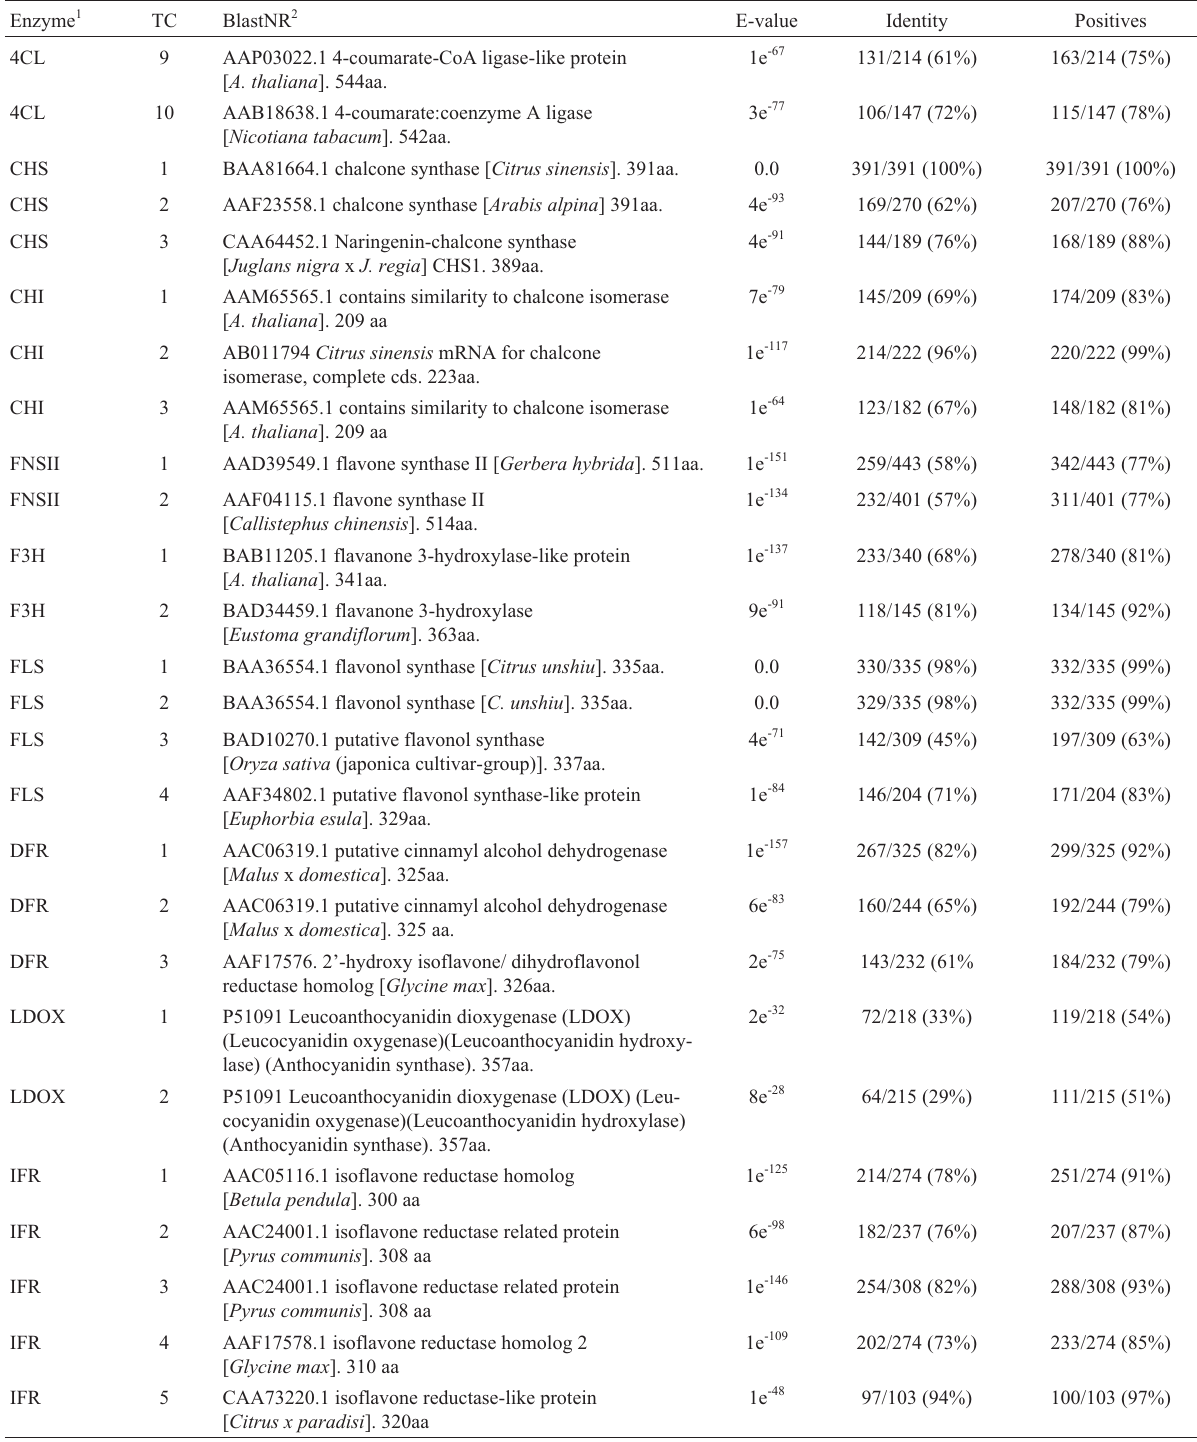
1 Enzymes: PAL = Phenylalanine ammonia-lyase; C4H = Cinnamate 4-hydroxylase; 4CL = 4-Coumarate CoA ligase; CHS = Chalcone synthase; CHI = Chalcone isomerase; FNSII = Flavone synthase II; F3H = Flavone 3-hydroxylase; FLS = Flavonol synthase; DFR = Dihydroflavonol 4-reductase, LDOX=LeucoanthocyanidinoxygenaseandIFR=Isoflavonereductase. 2 Besthitofnon-redundanttBlastxanalysisatNCBI(2006)databaseandavail- able sequence length (amino